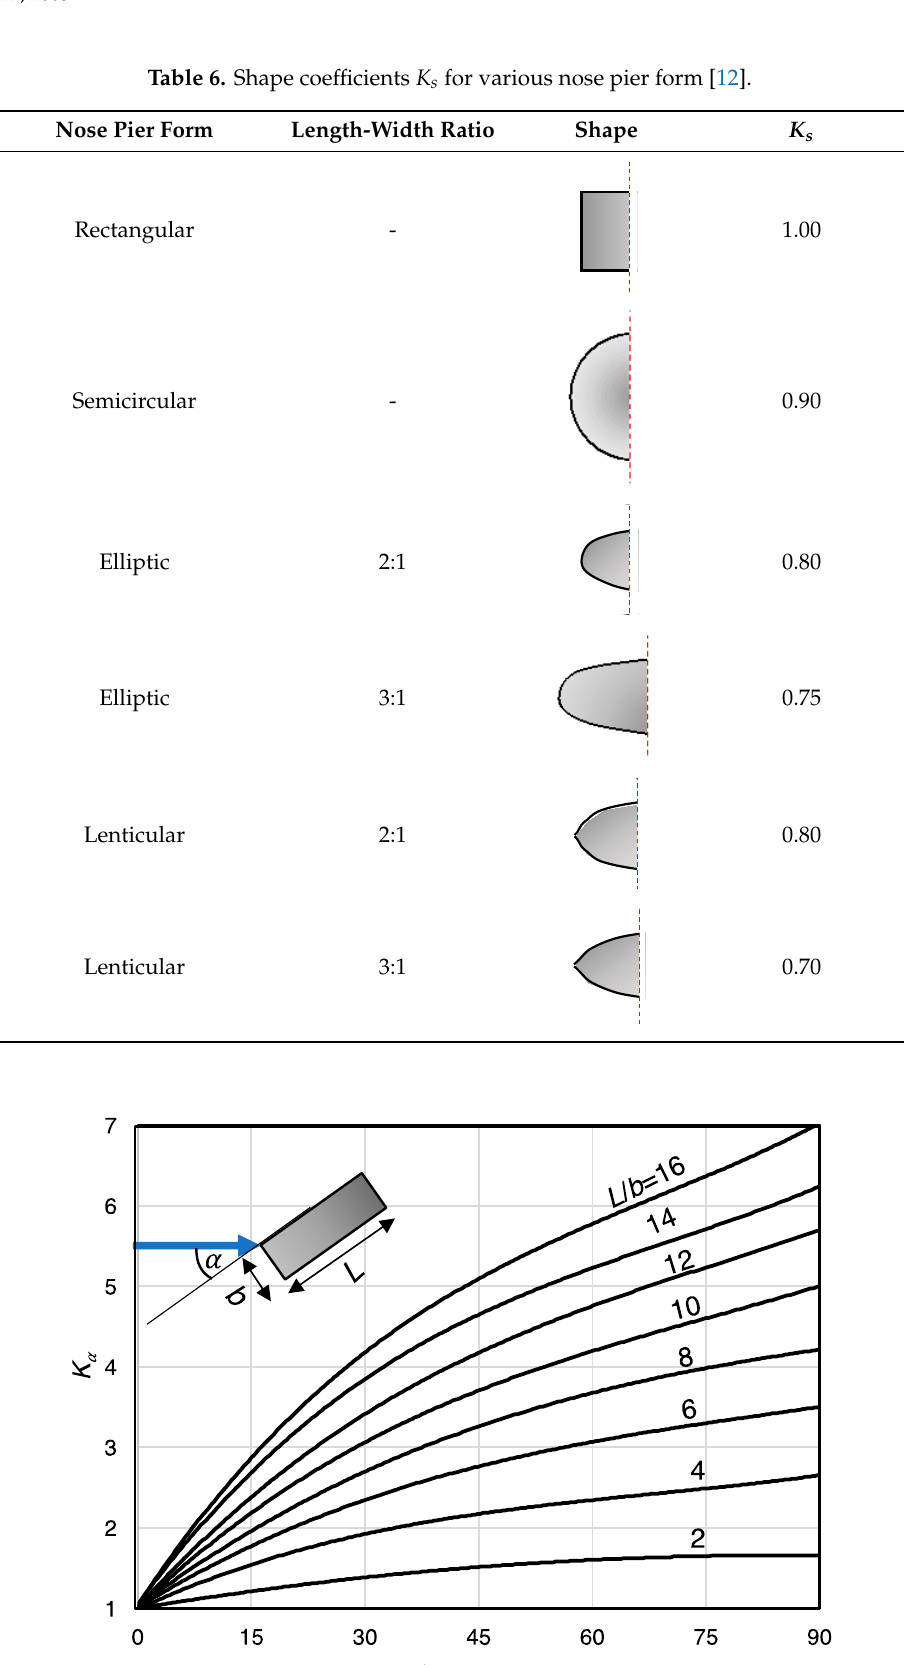
Figure 10. Design factor K α (according to Laursen and Toch [12]).